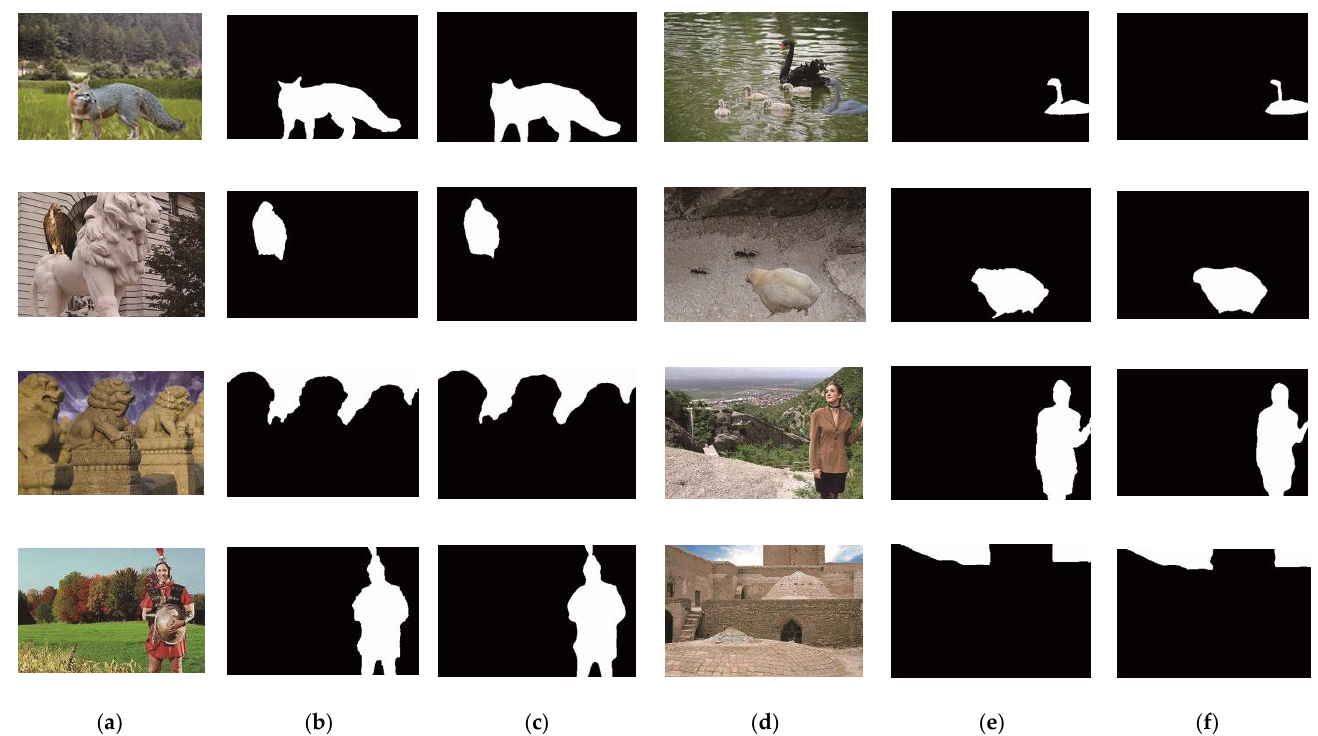
Figure 7. Detection results based on CASIA dataset. ( a ) Input image; ( b ) ground truth; ( c ) prediction; ( e ) input image; ( f ) ground truth; ( g ) prediction. ( d ) input image; ( e ) ground truth; ( f ) prediction.